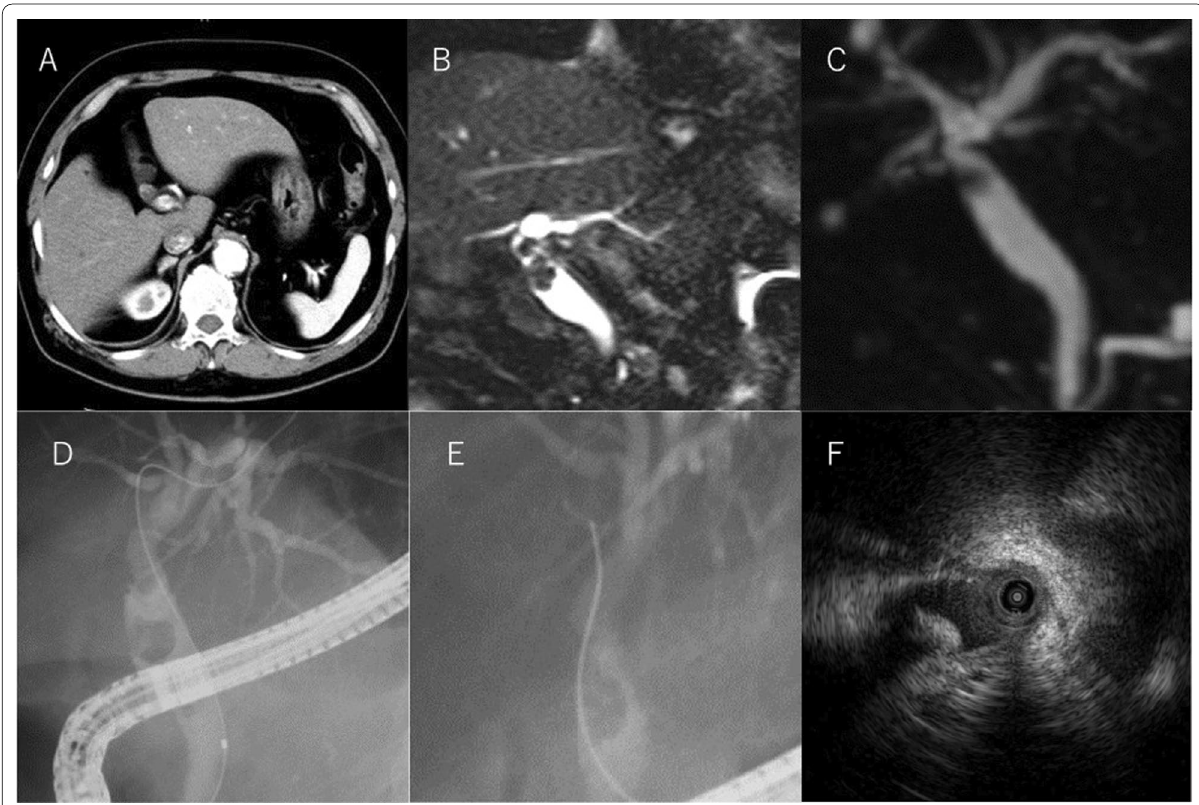
Fig. 3 Preoperative findings of choledocholithiasis in "Case 2". A CT image shows a mass located in the upper bile duct. B , C MRCP imaging shows a mass located in the upper bile duct. D , E ERCP image shows a filling defect in the upper bile duct, which suggests bile duct cancer. F Intraductal ultrasonography image reveals an intraductal